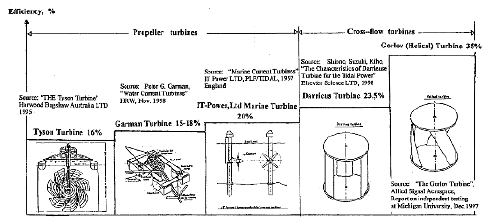
Figure 10. Power coefficient comparison in different types of tur- bines.